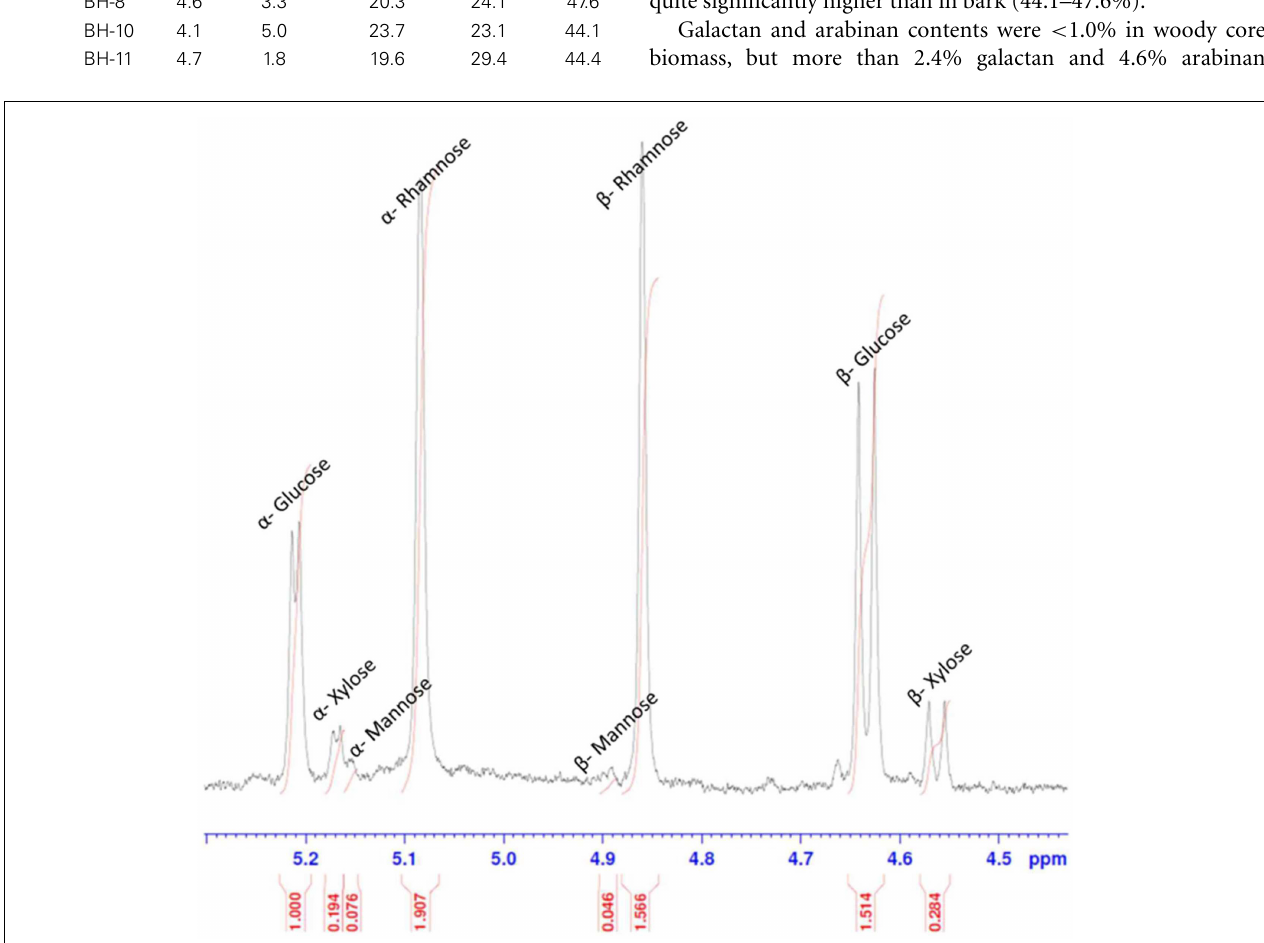
FIGURE 1 | 1H-NMR spectra of anomeric hydrogen peaks from monosaccharides in goat willow .